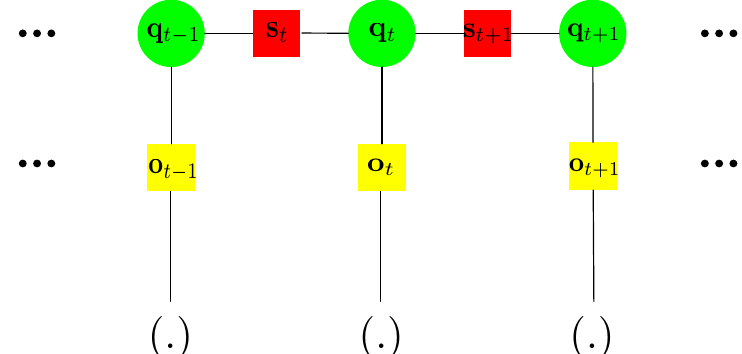
Figure 3. The factor graph representation of the cost function in Equation